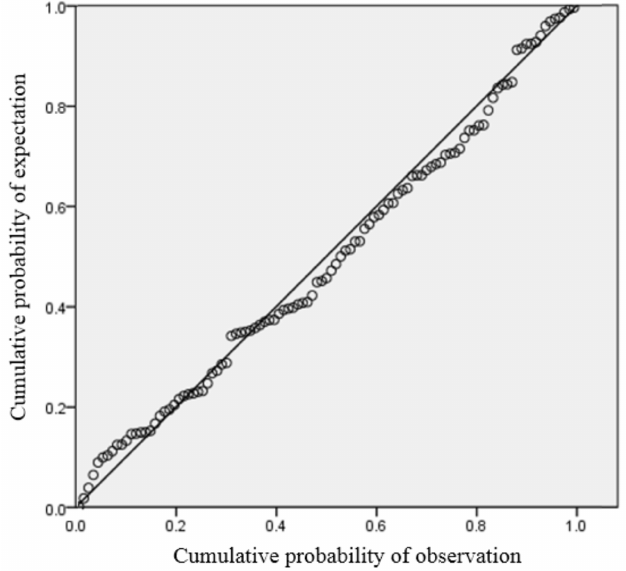
Figure 6. Standard P-P plots of regression normalized